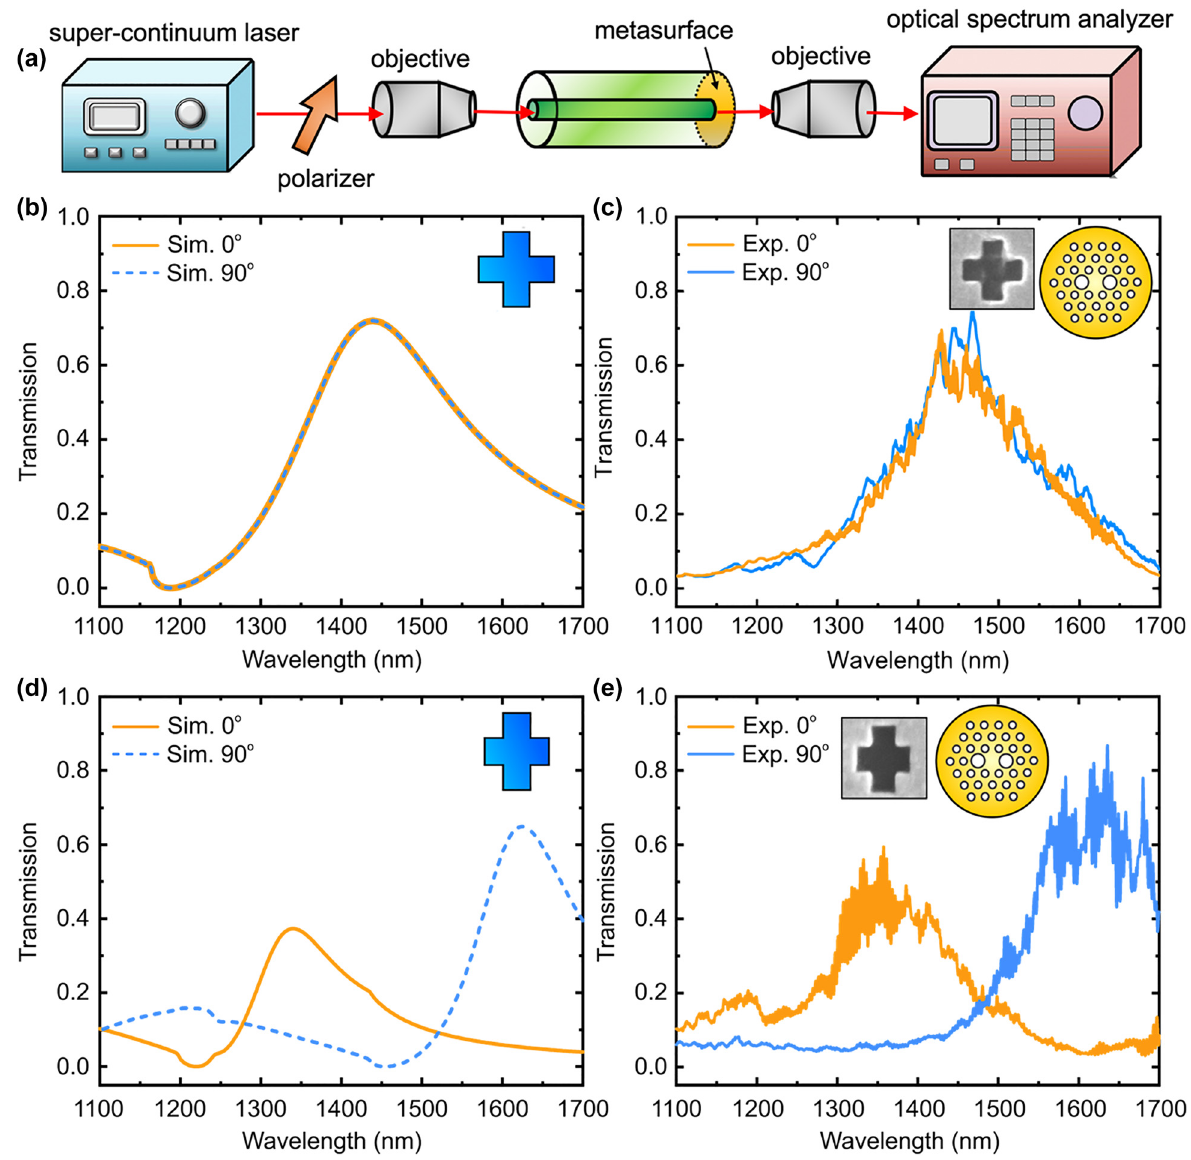
Figure 4: Transmission spectra for PM-PCF metasurface optical filter. (a) Schematic of experimental measurement setup. (b) Simulated and (c) measured transmission spectra for x - and y -polarization states for PM-PCFwithsymmetricnanocrossmetasurfaces.Symmetricnanocrossarrayhasunitelementwideof176nmandlengthoftheslitof490nm. (d) Simulated and (e) measured transmission spectra for x - and y -polarization states for PM-PCF with asymmetric nanocross